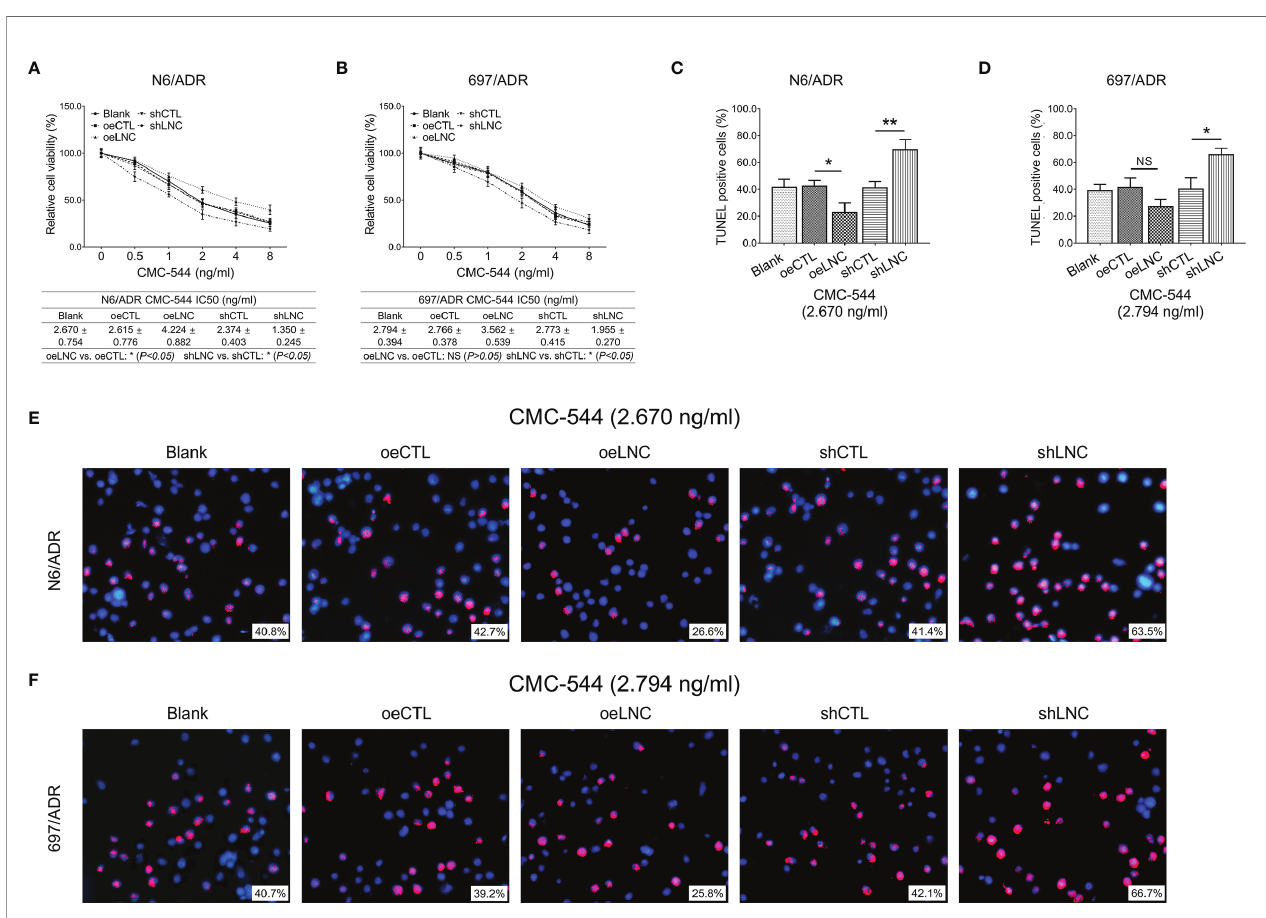
FIGURE 9 | Cell behaviors after lncRNA DUXAP8 modi fi cation and inotuzumab ozogamicin treatment. Relative cell viability (A, B) and cell apoptosis rate (C – F) among blank, oeCTL, oeLNC, shCTL, and shLNC groups in inotuzumab ozogamicin treated N6/ADR cells and 697/ADR